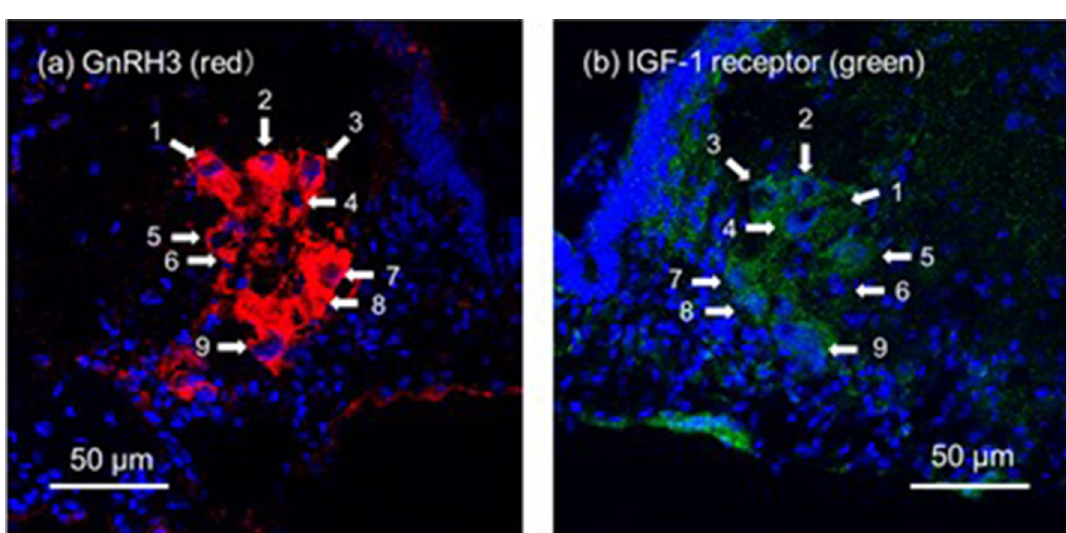
Figure 6. Representative images of gonadotropin-releasing hormone 3 (GnRH) neurons [red in (a)] and insulin-like growth factor 1 receptor immunoreactivities [green in (b)] on a pair of mirror-image frozen sections from 11-ketotestosterone-injected females. The same numerals in respective pictures indicate the same cells appearing on the two sections. Cell nuclei (blue) were stained with Hoechst